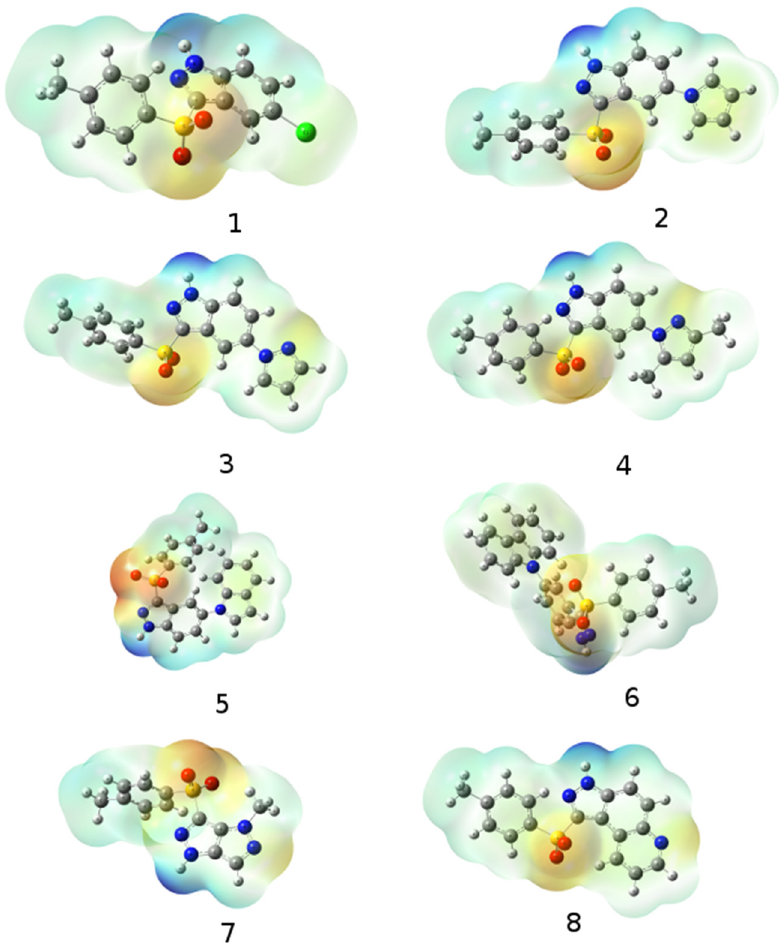
Figure 1: Electrostatic potential map of investigated azoles 1 – 8 ( B3LYP/6 - 311 ++ G ( 2d,3p ) //B3LYP - 631G ( d,p ) ; gaseous phase ) ; isovalue = 0.002 a.u.